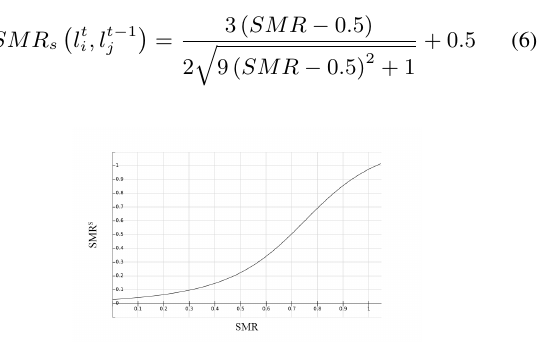
Figure 3. SMR Sigmoid Function